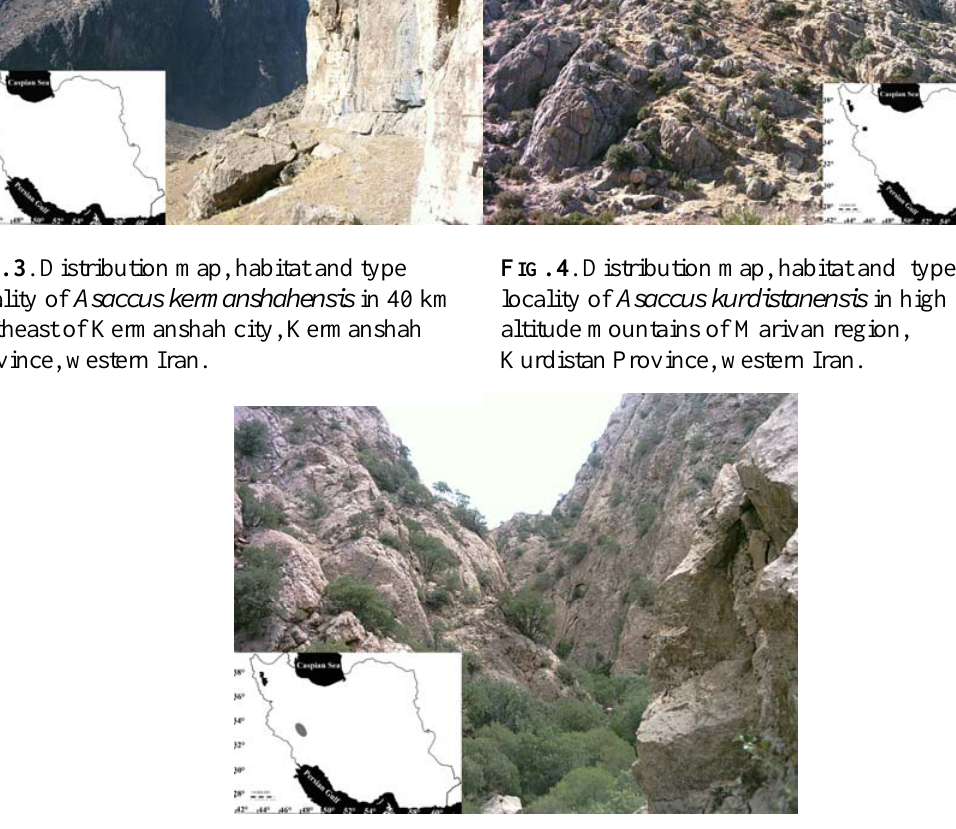
F IG . 5. Distribution map and typical habitat of Asaccus nasrullahi in the Zagrous Mountains with dense oak forest, Lorestan Province, western